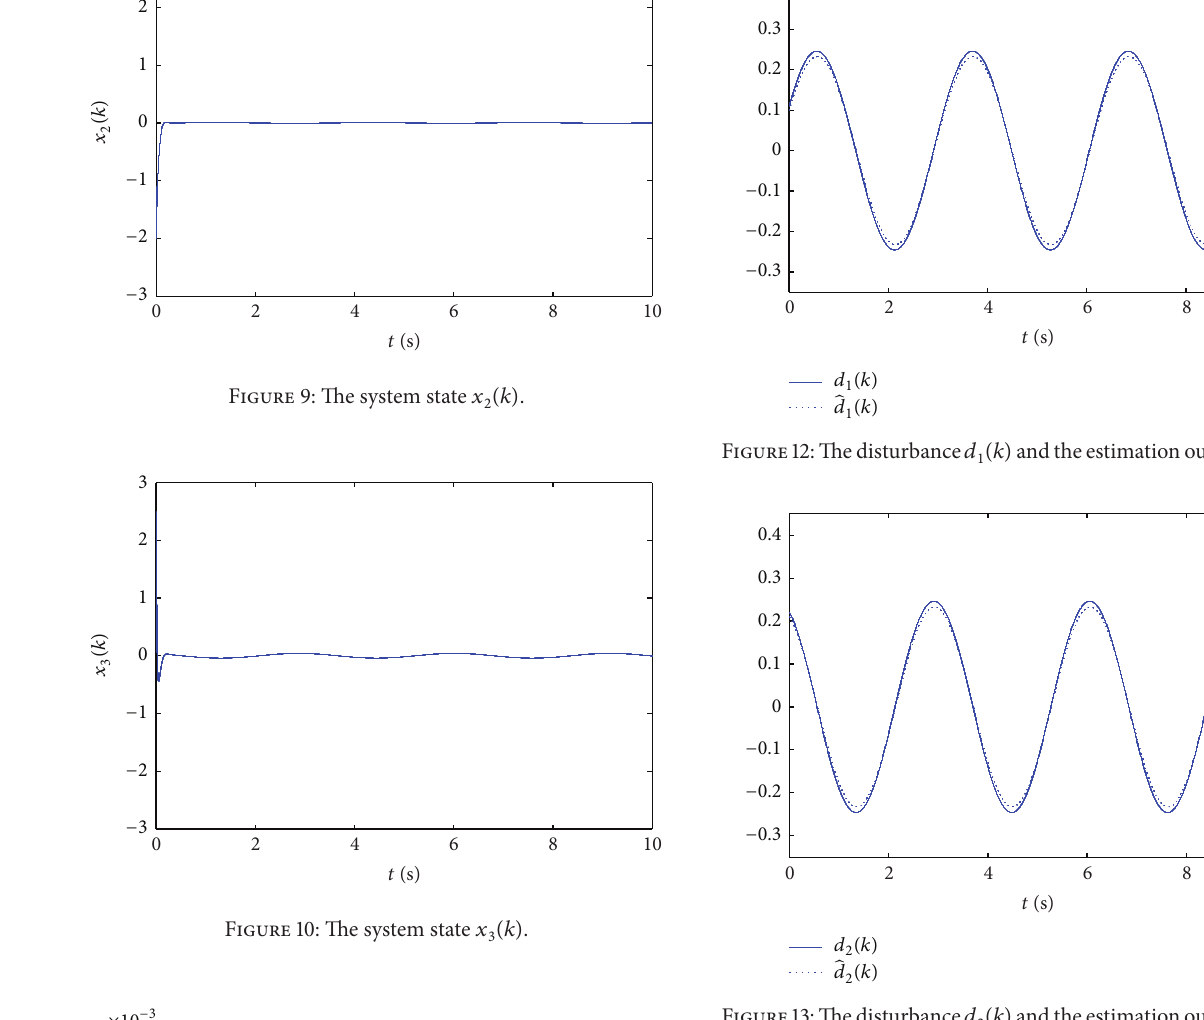
Figure 13: The disturbance 𝑑 2 (𝑘) and the estimation output of